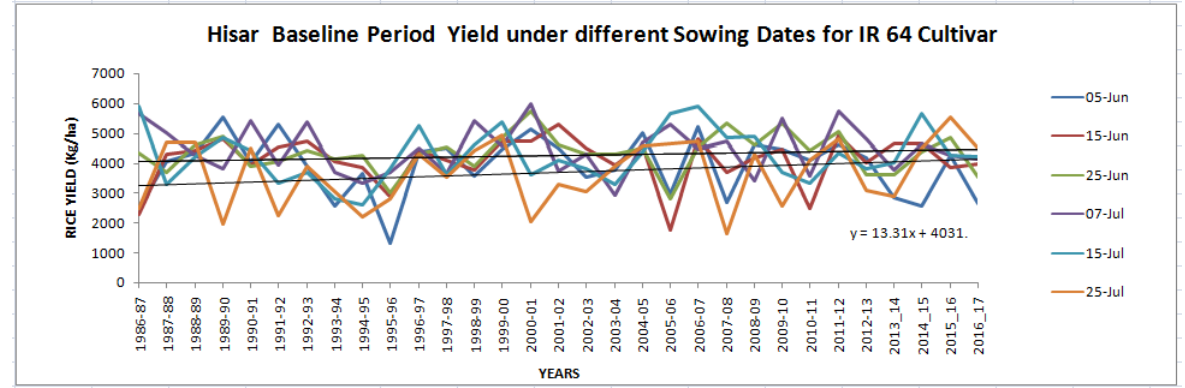
Figure 6: Simulated Rice Yield under different sowing environment for Baseline Period (1986-2016): HISAR